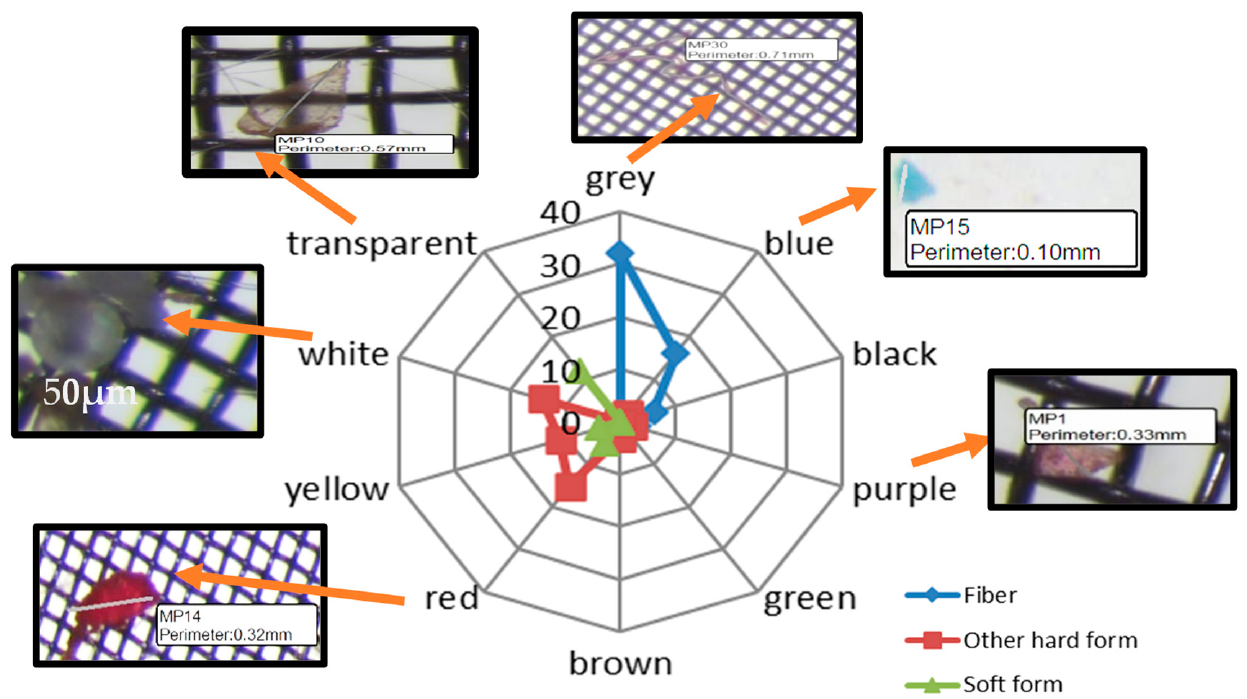
Figure 4. MP particles’ colour distribution with several examples captured by optical microscope. The authors would like to note that captured photos exhibit slightly different colours compared with real-time observation experiences. Table 1. The measured number of three identified morphotypes of MP particles depending on the filter mesh size of grey water and treated sewage samples.